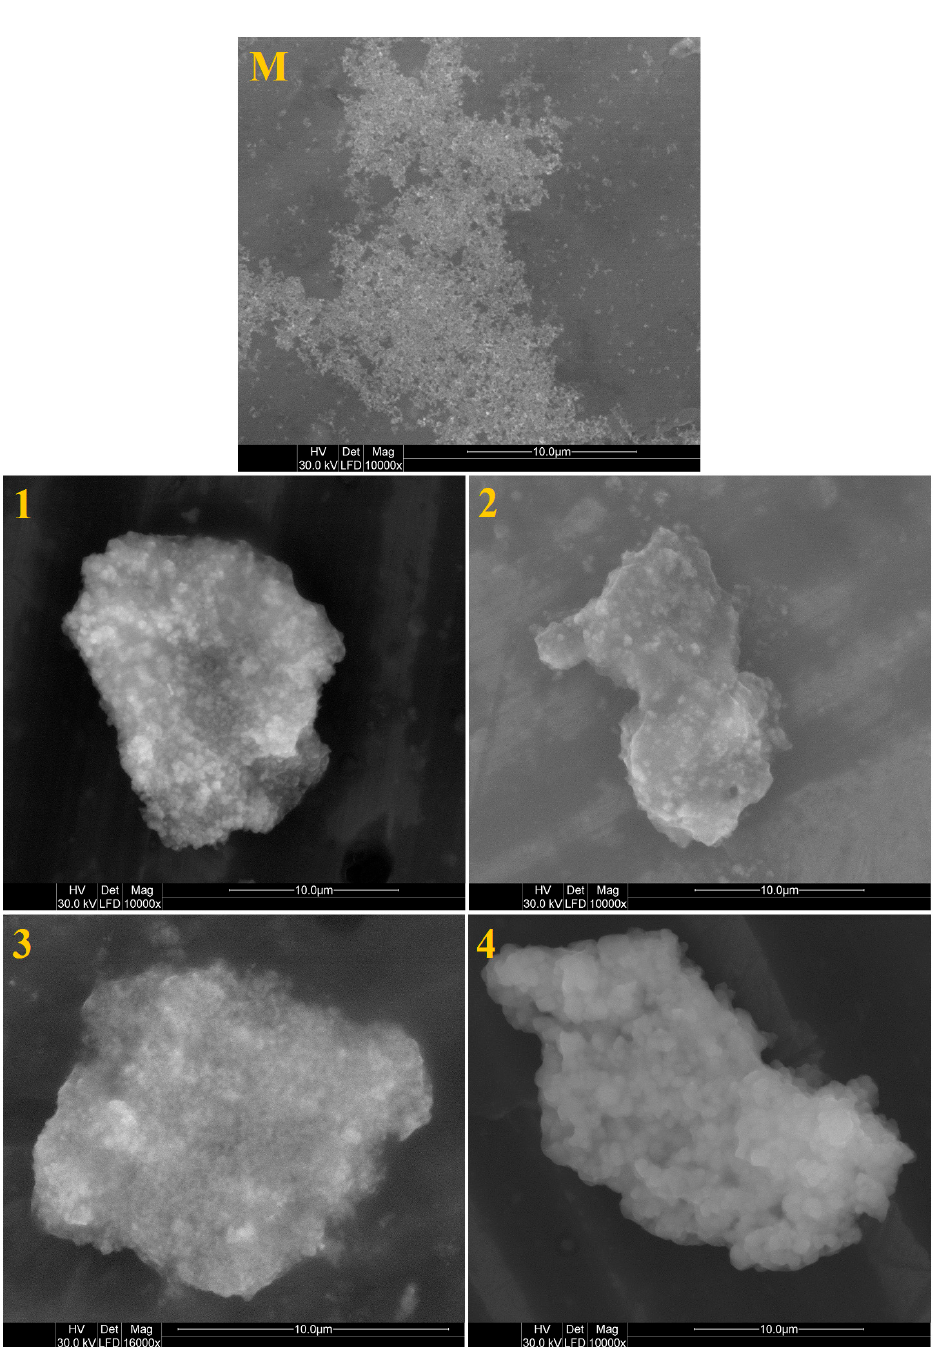
Figure 3. ESEM images of unfunctionalized ZnO nanoparticles (M) and of ZnO nanoparticles modified with (1) GPTMS; (2) PhTES; (3) OTES; and (4) ODTES, respectively.